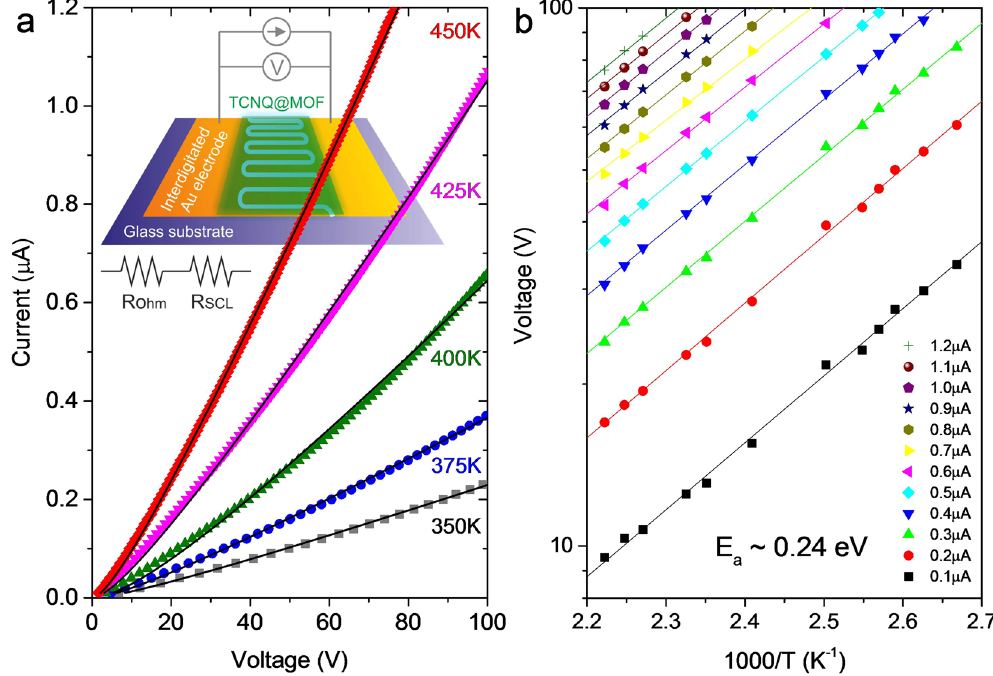
Figure 5. ( a ) Current–voltage (I-V) data for TCNQ@Co-MOF-74 measured at 350, 375, 400, 425 and 450 K, fit to V = α I + bI 0.5 (solid curves) assuming that the measured resistance is expressed as ohmic ( I ∝ V Ohm ) and 2 ) resistances connected in series. Inset: a diagram for transport measurements on space charge limited ( ∝ I V SCL a TCNQ@Co-MOF-74 film deposited on an interdigitated gold electrode. ( b ) Voltages versus inverse temperature measured at different currents from I = 0.1 μ A up to 1.2 μ A. The solid lines are Arrhenius